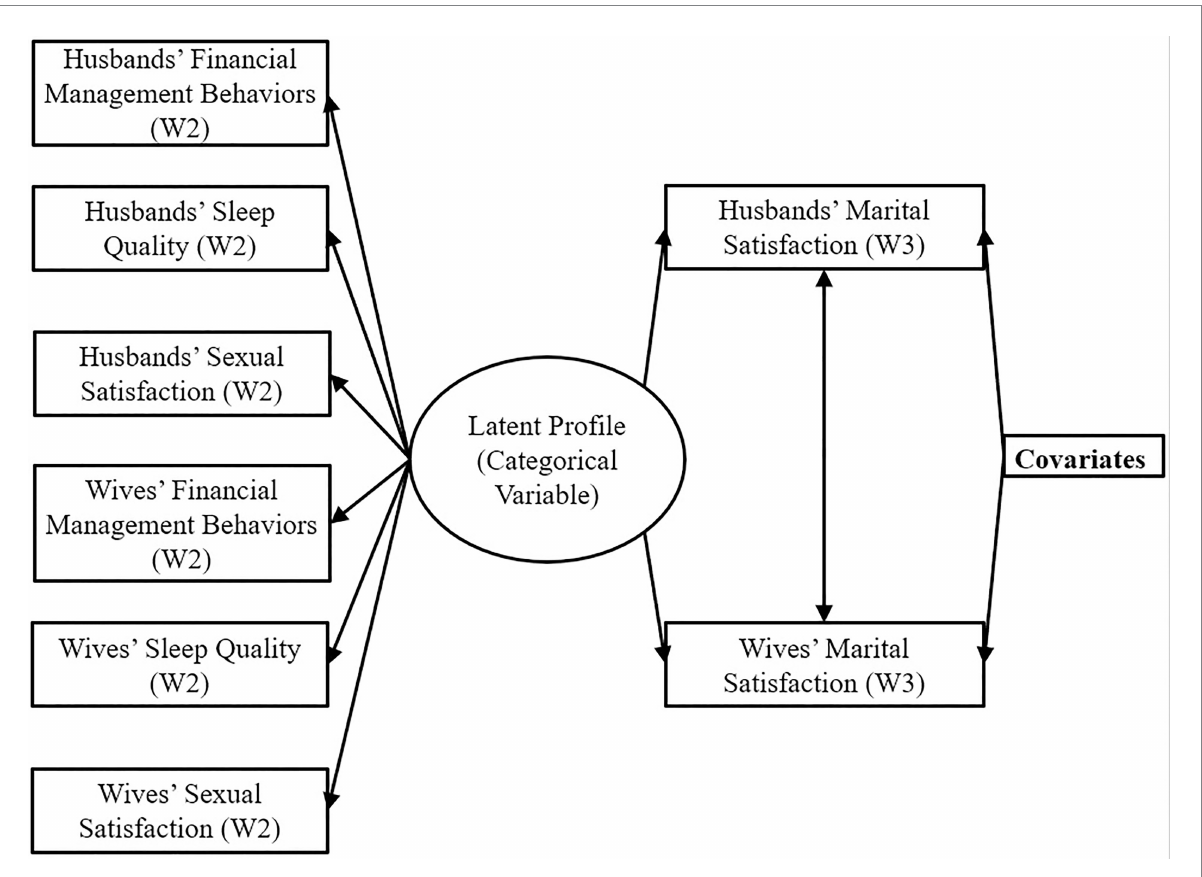
FIGURE 1 Dyadic latent profile analysis analytical